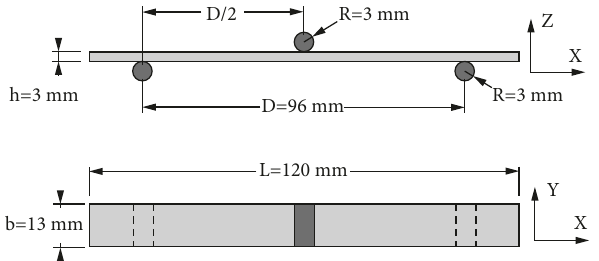
Figure 3: Schematic diagram of the specimen size and test configuration.